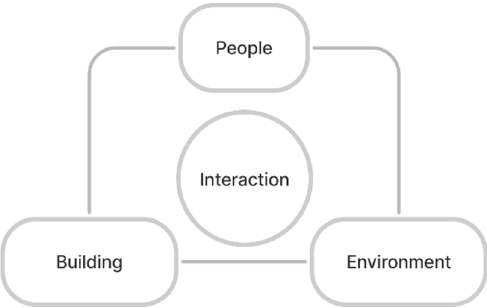
Figure 1. The interaction of people, buildings, and the environment.